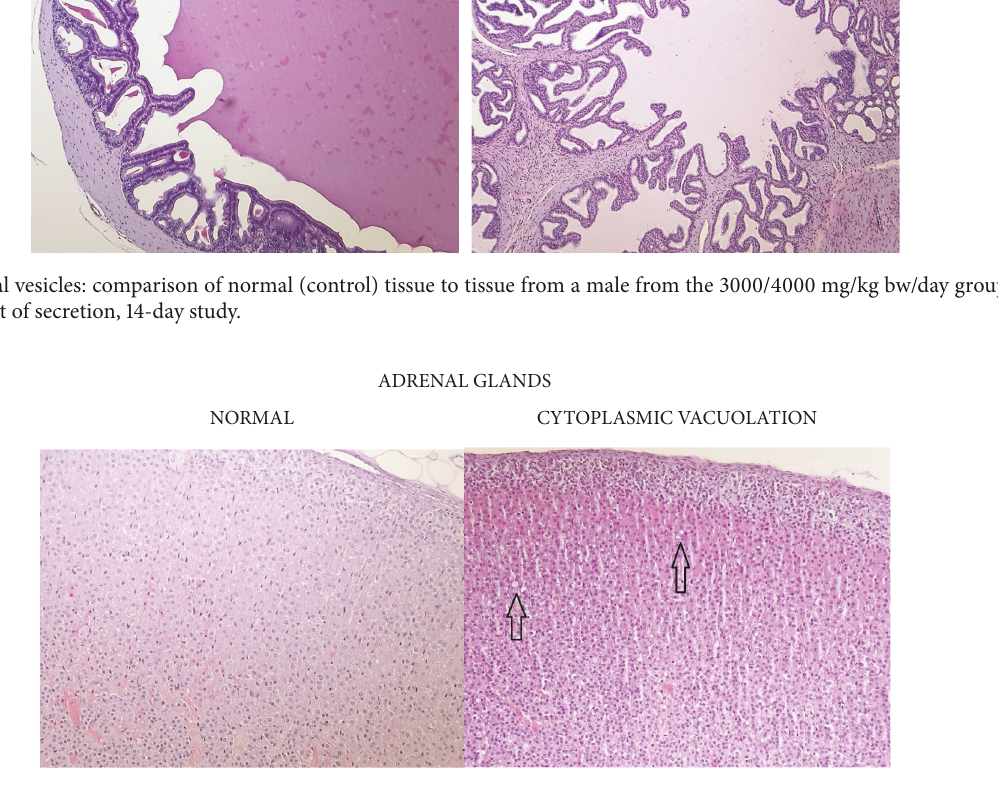
Figure 6: Adrenal cortex: comparison of normal (control) cortical cells to cells in an animal from the 720 mg/kg bw/day group showing cytoplasmic vacuolation, 90-day